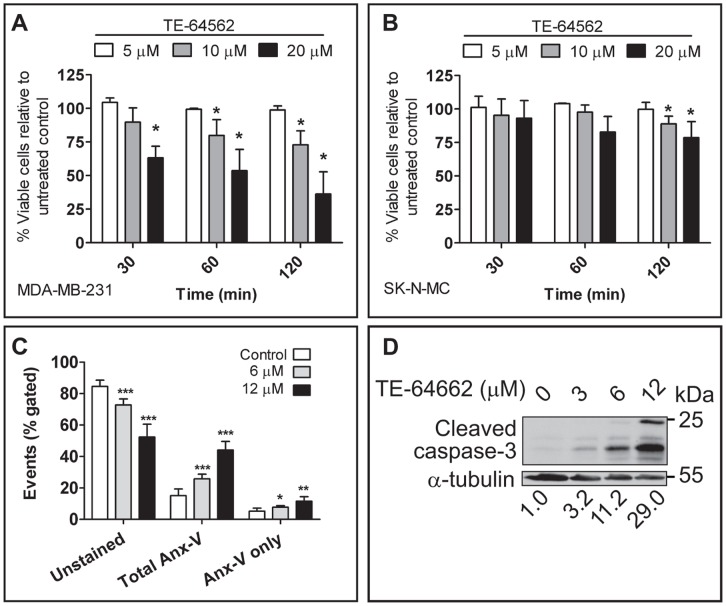
TE-64562 treatment causes early non-apoptotic cell death and induces apoptosis after longer treatment.Serum starved (A) MDA-MB-231 cells or (B) SK-N-MC cells were treated overnight with 5, 10 or 20 µM of TE-64562 for 0.5, 1 or 3 hours and assayed for cell viability. Data were averaged from three independent experiments and plotted with the error bars representing the standard deviation from the mean. Significant differences were assessed between each treatment condition and untreated control (*P<0.05 from a two-tailed unpaired t test). (C) MDA-MB-231 breast cancer cells were serum starved overnight then treated with 0 (control), 6 or 12 µM TE-64562 for 18 hours. Cells were stained with Annexin-V and propidium iodide (PI) and the mean results from four independent experiments are plotted. Unstained cells represent viable cells; total Annexin V staining (Anx-V) is the sum of the Anx-V-stained and dually stained cells which are undergoing apoptosis or are fully apoptotic or necrotic; and Anx-V only stained cells are undergoing apoptosis. Significant differences were assessed between each treatment condition and untreated control (*P = 0.028; **P = 0.008; ***P = 0.004). (D) Serum starved MDA-MB-231 cells were treated with 0 (control), 3, 6 or 12 µM TE-64562 for 18 hours. Cells were lysed, analyzed by Western blot and probed for the presence of cleaved caspase-3. Numbers below the blot images represent the quantifications of each band normalized to the respective control. The blot is representative of two independent experiments. All error bars represent standard error of the mean. Also see Figure S3.